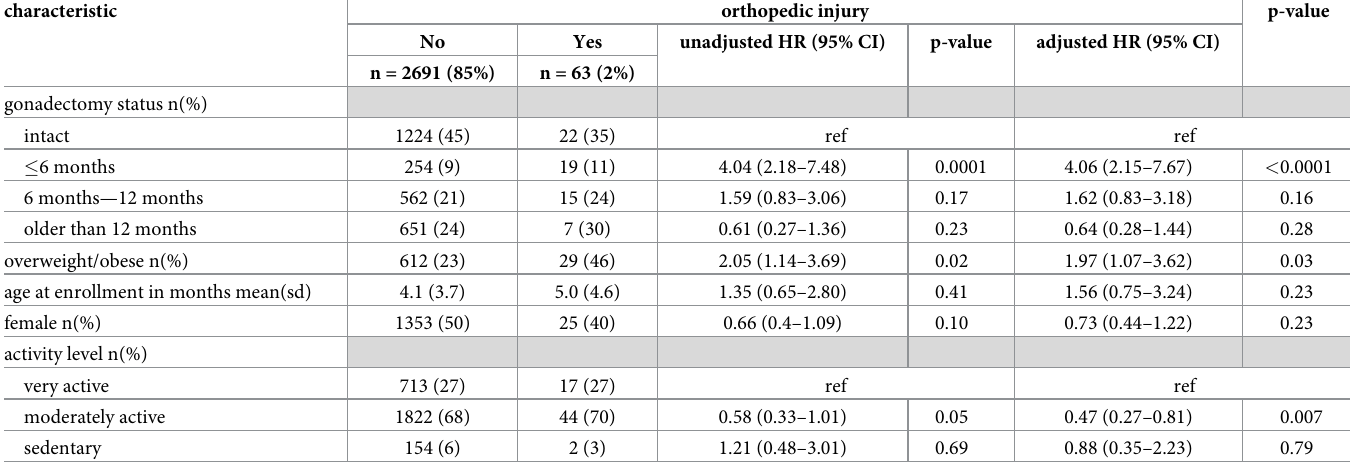
Table 2. Descriptive characteristics, unadjusted, and adjusted hazard ratios for the risk for orthopedic injury in a cohort of Golden Retrievers as a function of gonadectomy. characteristic